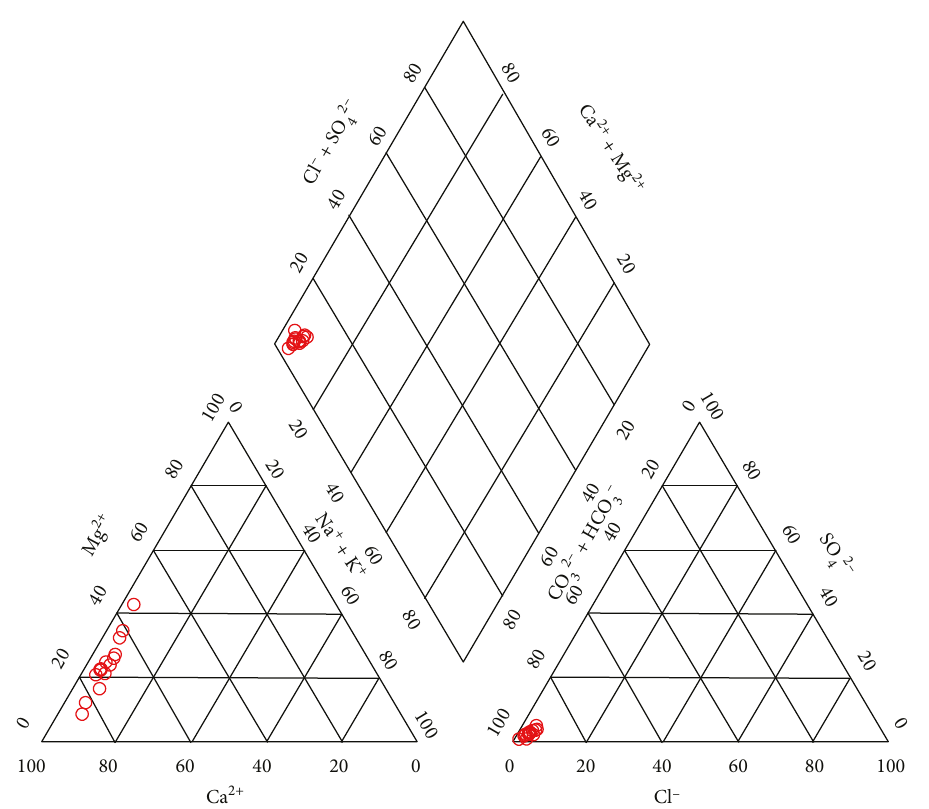
Figure 4: Piper diagram showing the groundwater hydrogeochemical